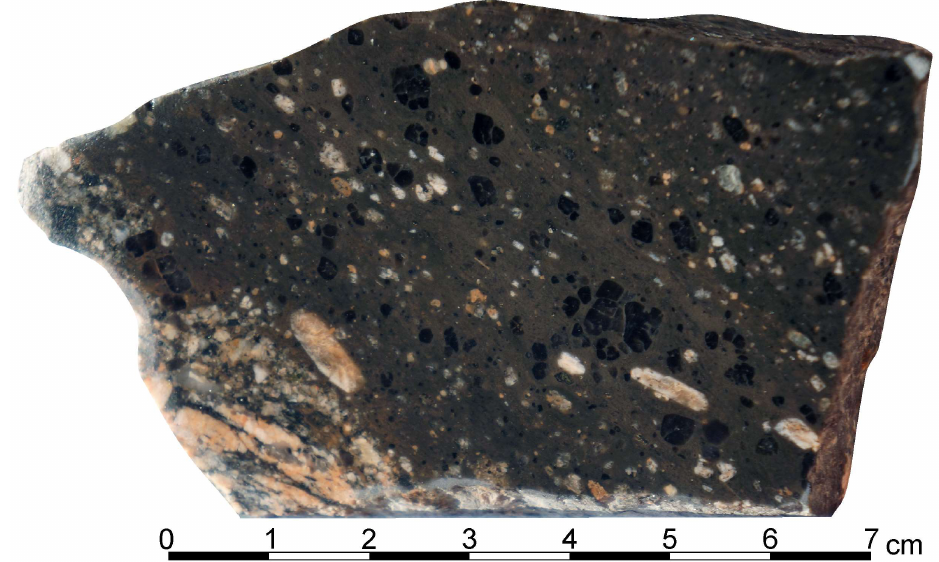
Figure 4. Polished cut of the granite porphyry considered in this work. Sample AK220617-1_2. Two types of xenolith are present, i.e., host rocks and older granite, namely (I) quartz-biotite-feldspar gneiss (AR 2 -PR 1 ), amphibolites and mica schists of the Sortavala